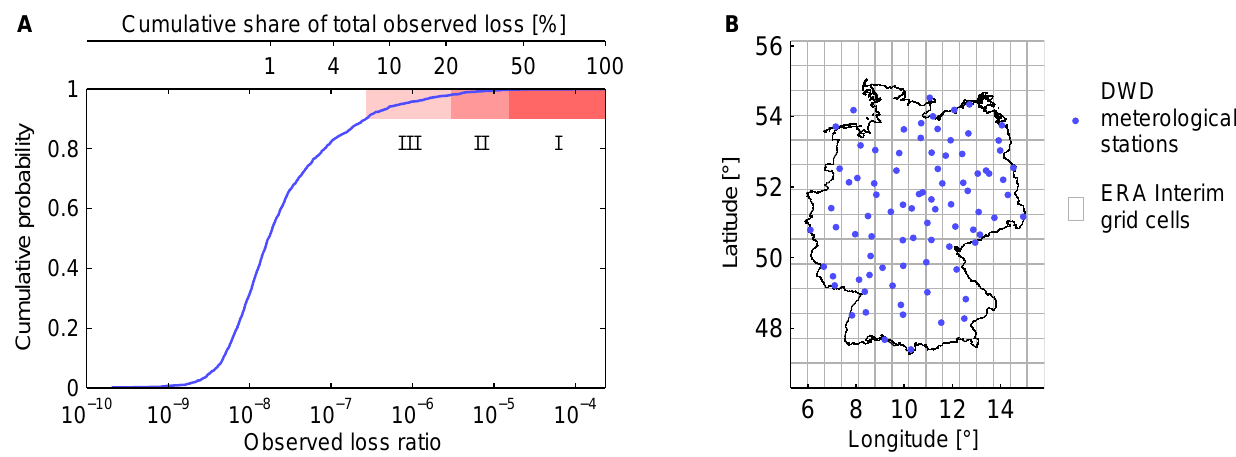
Figure 1. (a) shows the empirical cumulative distribution function of loss days in Germany during the winter half-year. The observations comprise 2000 loss days, which exhibit a steep increase of loss at the upper end of their distribution. The shaded area indicates the days within the upper 0.1 quantile, subdivided into the three loss classes defined in Table 1. The top scale shows the share of total loss that is accumulated for all losses smaller than or equal to a specific loss ratio. (b) shows the spatial distribution of the employed DWD stations and the ERA-Interim grid cell